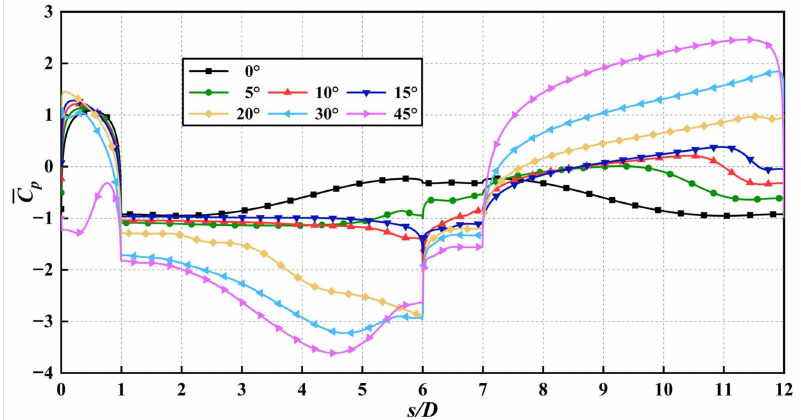
Figure 16. Time-average pressure coefficient distribution on the cylinder